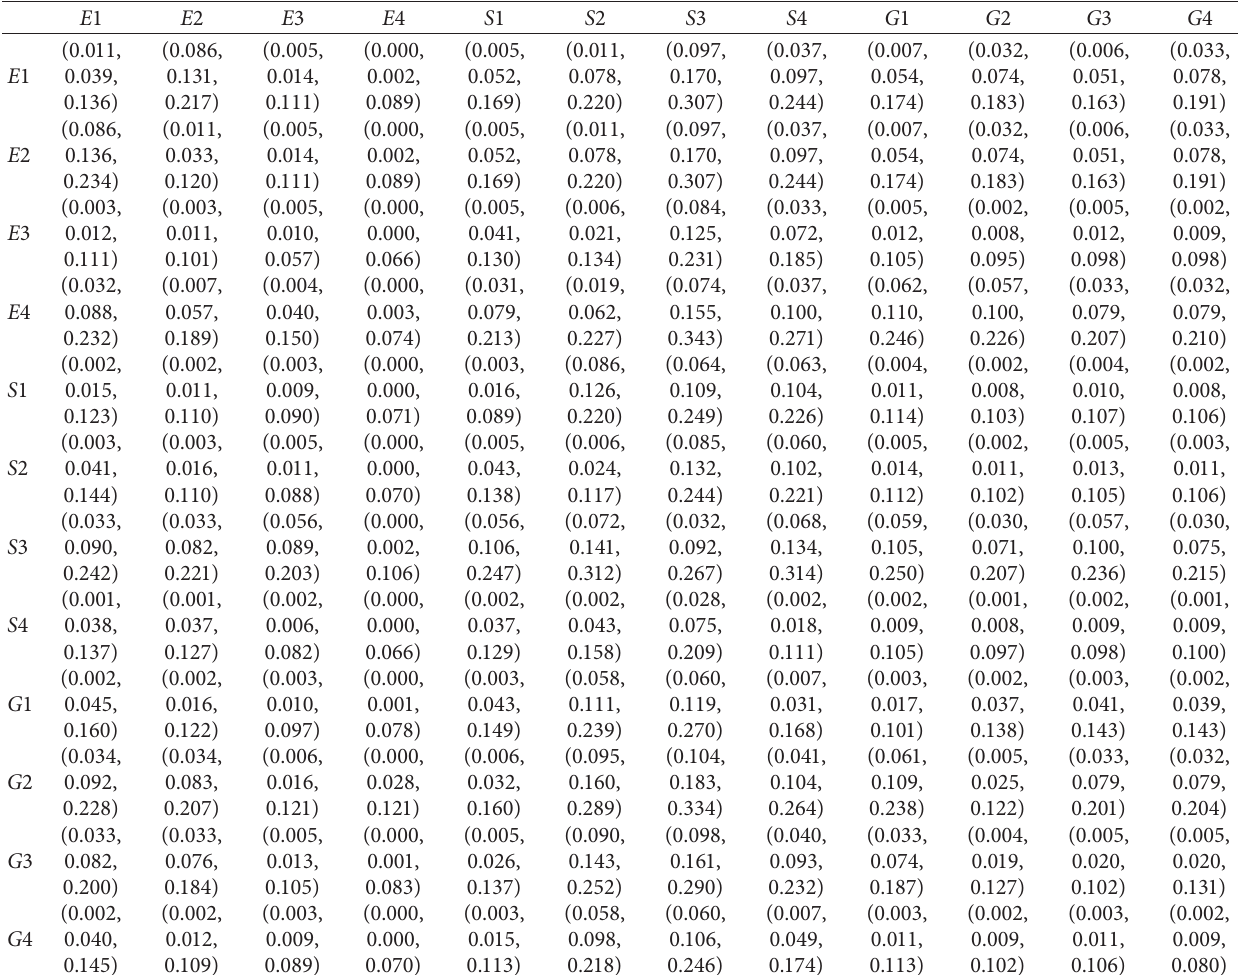
Table 40: Total relationship matrix of sustainability criteria in fuzzy condition.